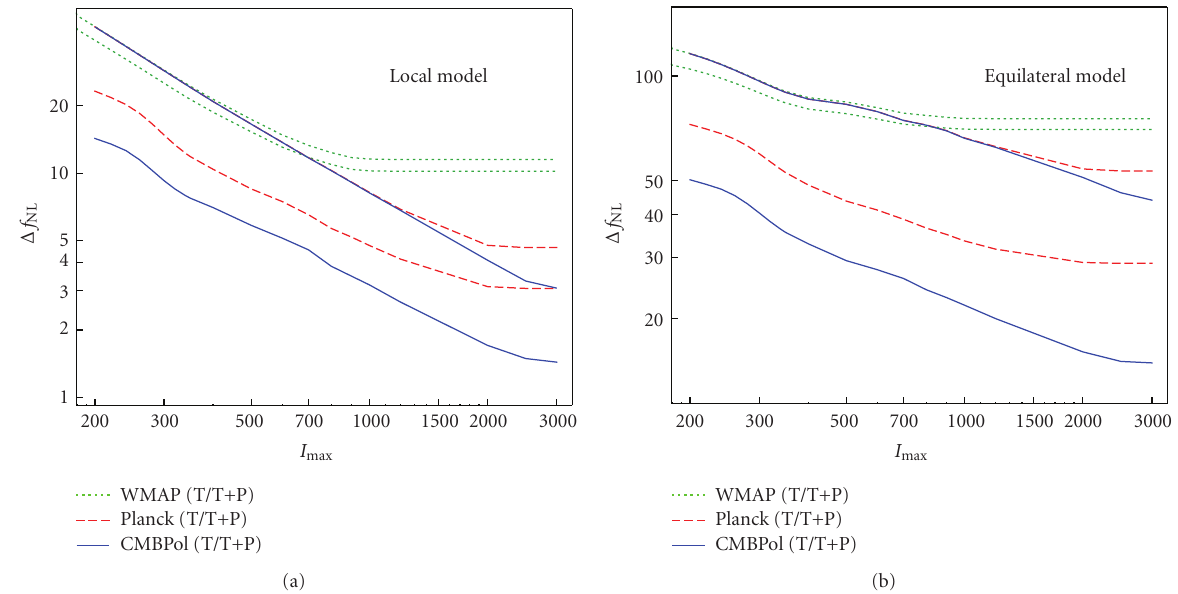
Figure 11: The Fisher matrix forecasts on Δ f NL , featured for di ff erent experiments: WMAP ( green, dotted lines ), Planck ( red, dashed lines ), and the proposed CMBpol [90] survey ( blue, solid lines ). (a) shows results for the local shape, while (b) refers to the equilateral shape. Thin lines are obtained from temperature data only, and thick lines show the improvement in the error bars coming from adding polarization datasets to the analysis for the various